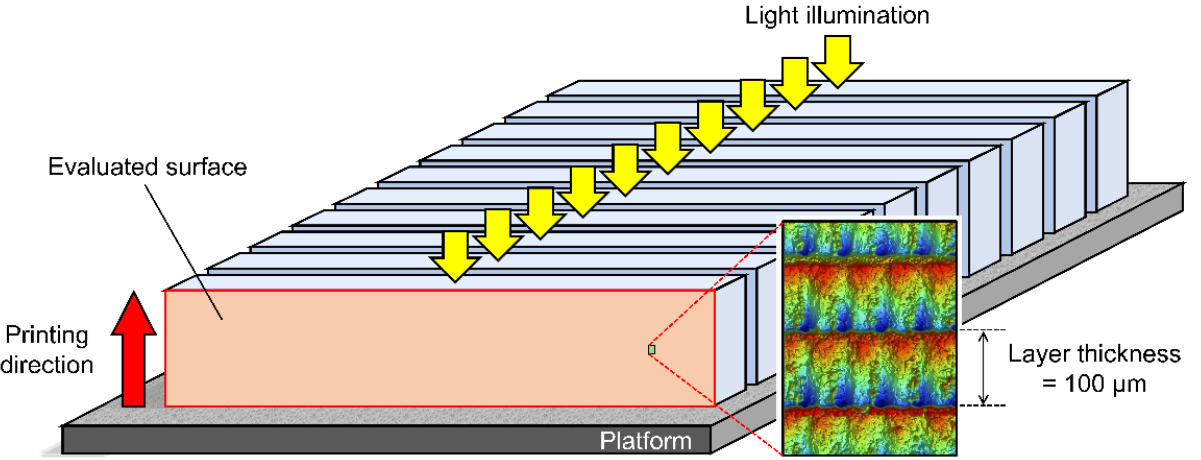
Figure 3. The printing direction (red arrow), direction of light illumination (yellow arrows), and evaluated surface for Vickers hardness number (VHN) testing and optical observation.